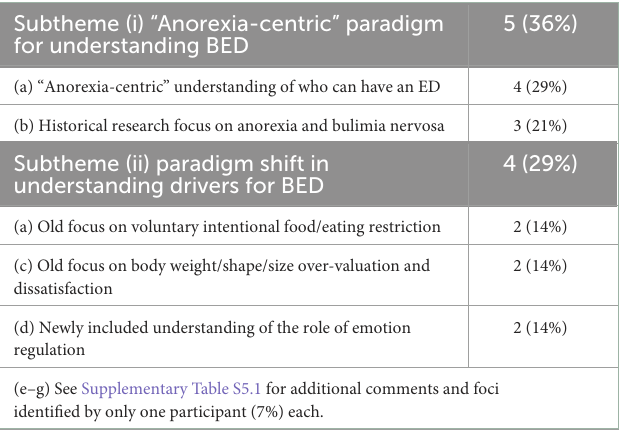
TABLE 12 Participant responses consistent with theme 5 “paradigm shifts”. Subtheme (i) “Anorexia-centric” paradigm for understanding